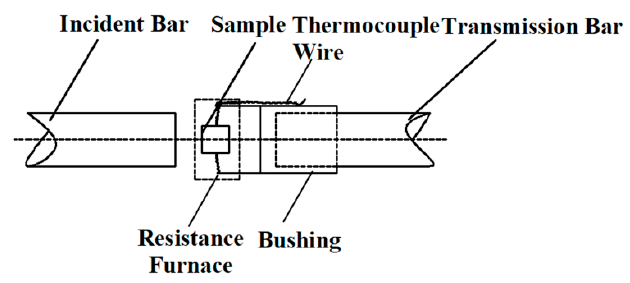
Figure 7. Schematic diagram of sample clamping.